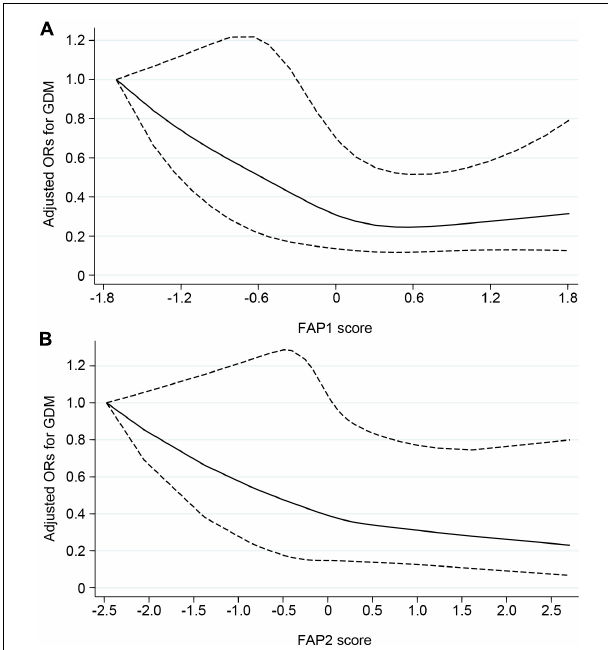
FIGURE 4 | Potential non-linear associations of FAP1 (A) and FAP2 (B) with odds of GDM assessed by restricted cubic spline model. Solid line indicated adjusted ORs for GDM, and dashed line indicated 95% CIs. Adjustments were made for age, gestational age at blood collection, parity, prepregnancy BMI, family history of diabetes, smoking and alcohol use. FAP, fatty acid pattern; GDM, gestational diabetes mellitus; ORs, odds ratios; CIs, confidence